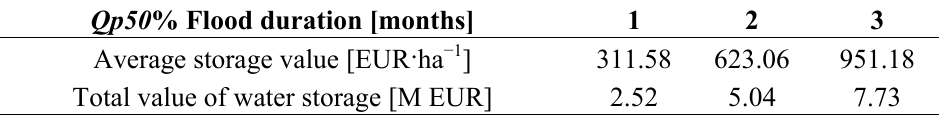
Table 3. Selected monetary values of floodplain water